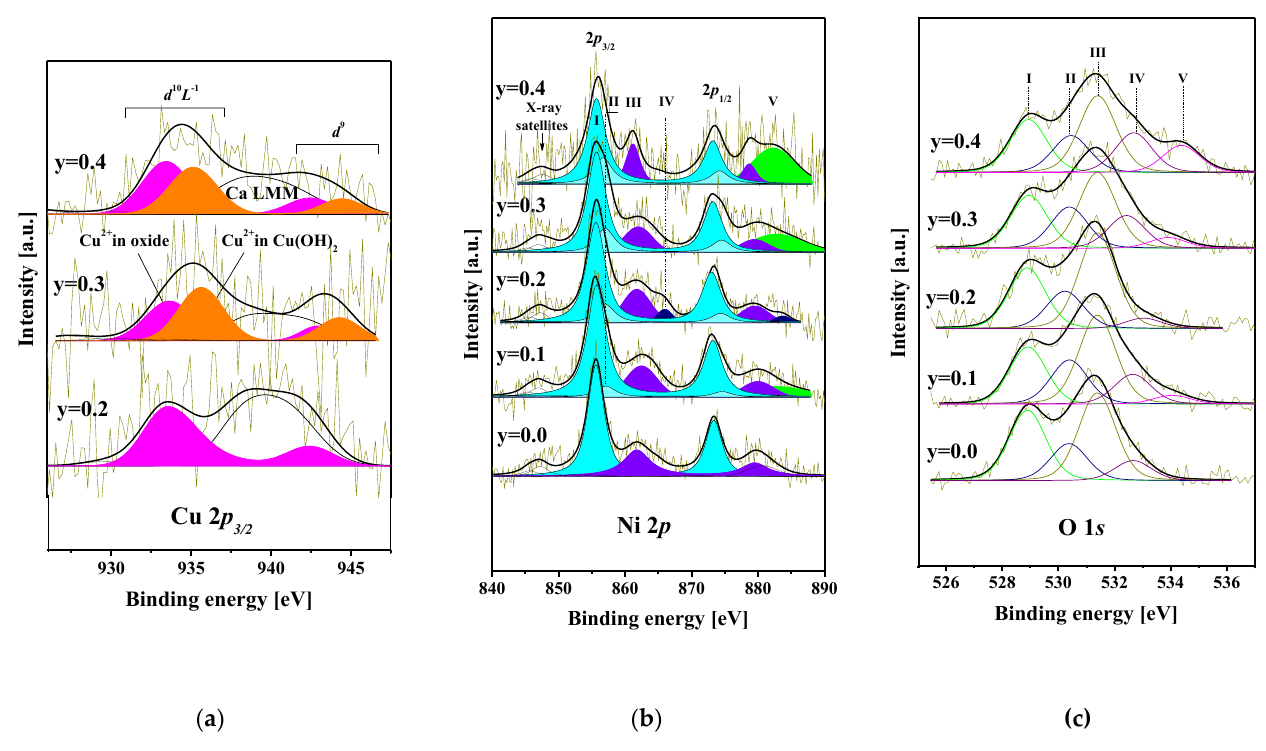
Figure 6. XPS spectra obtained in air at room temperature for the NCNCO samples with different Cu content: Cu 2 p 3/2 ( a ); Ni 2 p ( b ); and O 1 s ( c ). content: Cu 2 p 3/2 ( a ); Ni 2 p ( b ); and O 1 s ( c ).